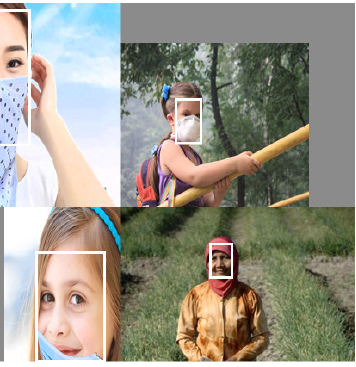
Figure 4. Mosaic data enhancement.